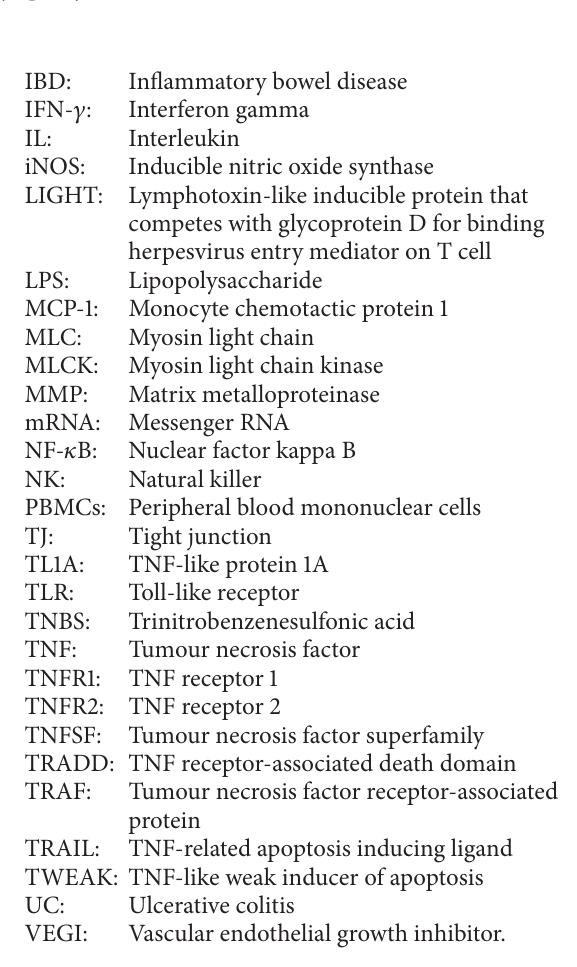
Figure 1: Two major mechanisms which implicate the molecules belonging to the TNFSF in the pathomechanisms of IBD. (a) Disruption of intestinal epithelium integrity allows luminal bacterial antigens to cross the epithelial barrier and migrate into the intestinal mucosa where they elicit immune responses. (b) Activation of mucosa-infiltrating T